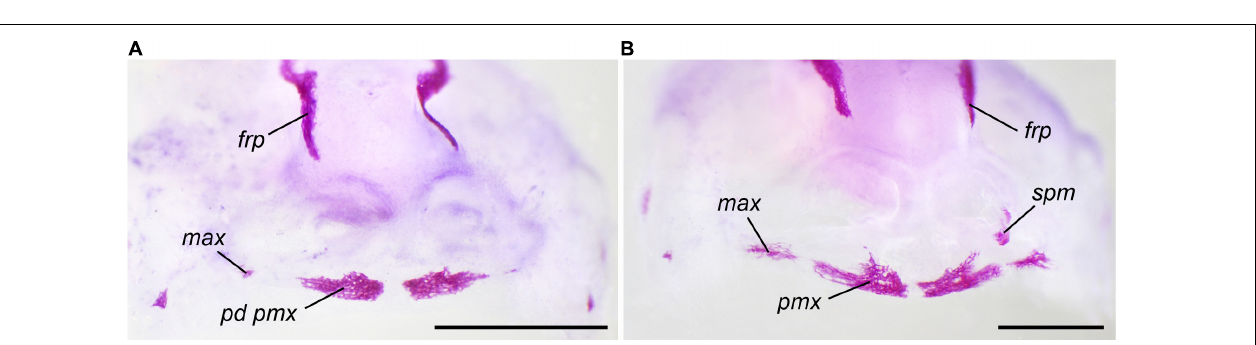
FIGURE 3 | Development of the premaxilla in Bombina variegata : (A) in T 3 2 × 10 − 8 M (early), Stage 35, 18 dph; (B) in TU 0.02%, Stage 43, 75 dph. For abbreviations, see Figures 1 , 2 . Scale bar 1 mm.